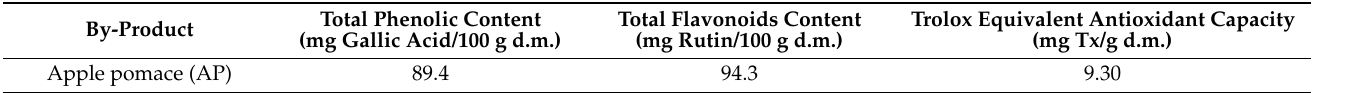
Table 1. Antioxidant compounds and antioxidant activity in apple pomace. Total Phenolic Content By-Product (mg Gallic Acid/100 g